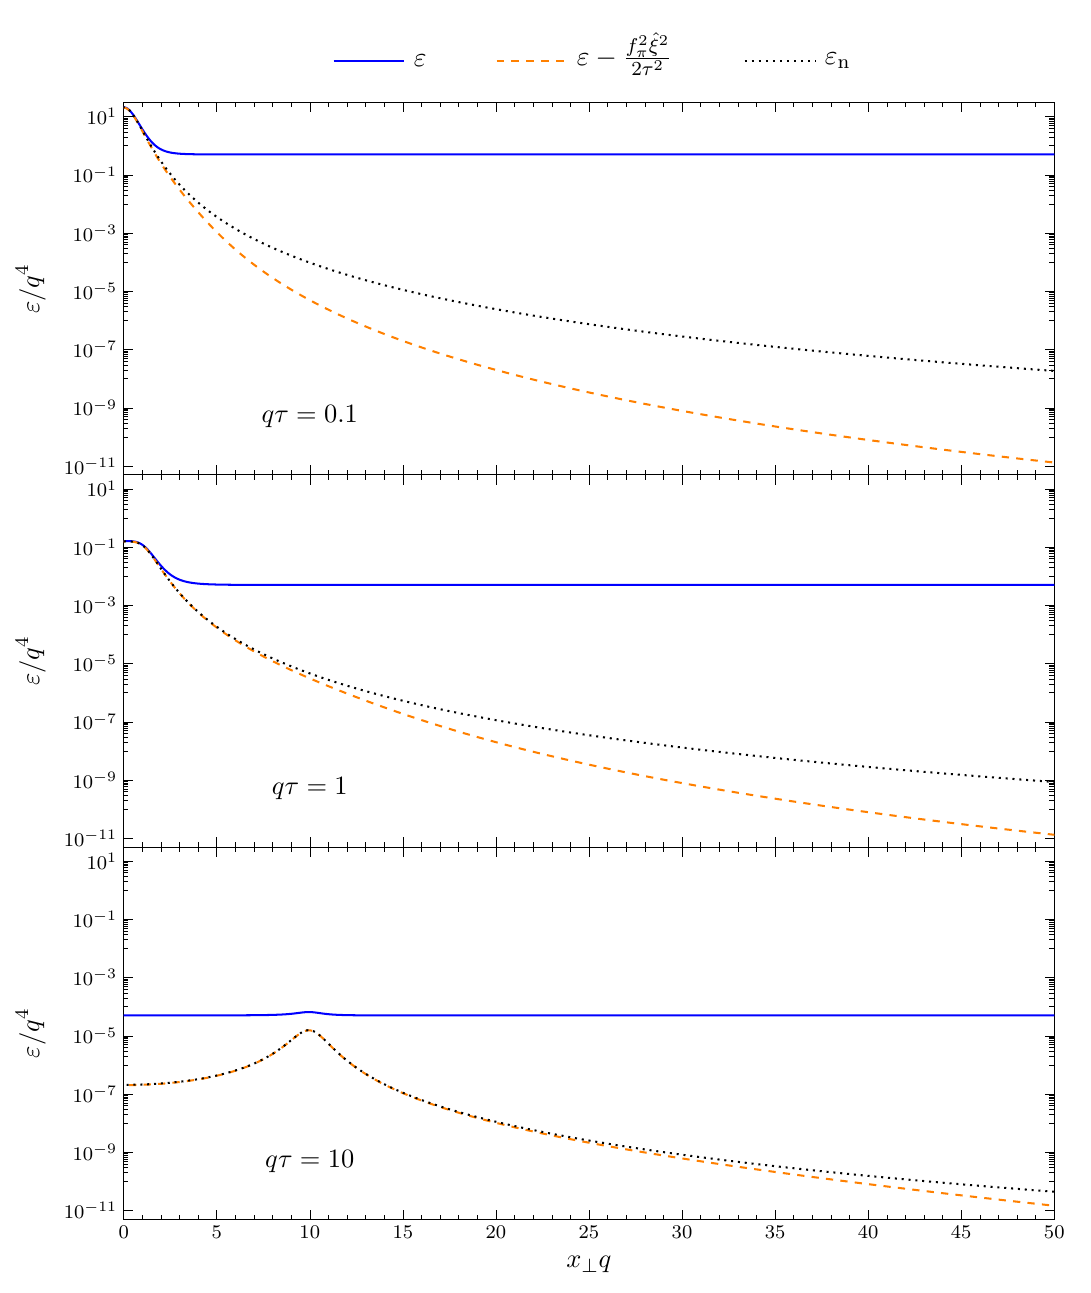
Figure 2. Sample logarithmic plots of the energy density of ideal superfluid Gubser flow as a function of transverse distance x ⊥ , at different Milne times τ . To make these plots, we have fixed the parameters of the model and the solution to n = π 2 / 30 , k = 1 / 6 , q = f π , ˆ ξ = 1 / 10 , and τ 0 = 1 /f π . The solid blue curves show the energy density (4.17). The dashed orange curves show the same energy density (4.17), but with the x ⊥ -independent contribution f 2 order to make the x ⊥ -dependence clearer. The dotted grey curves show the normal fluid result (4.8), with ˆ ε 0 chosen such that the two results agree at qτ = 0 . 1 and x ⊥ = 0 , for